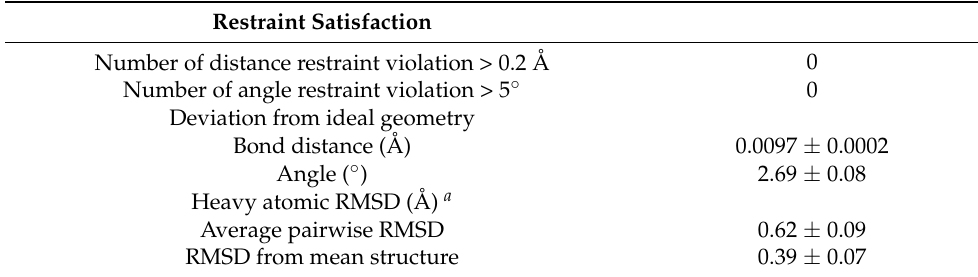
Table 2. NMR refinement statistics of the m 1 A